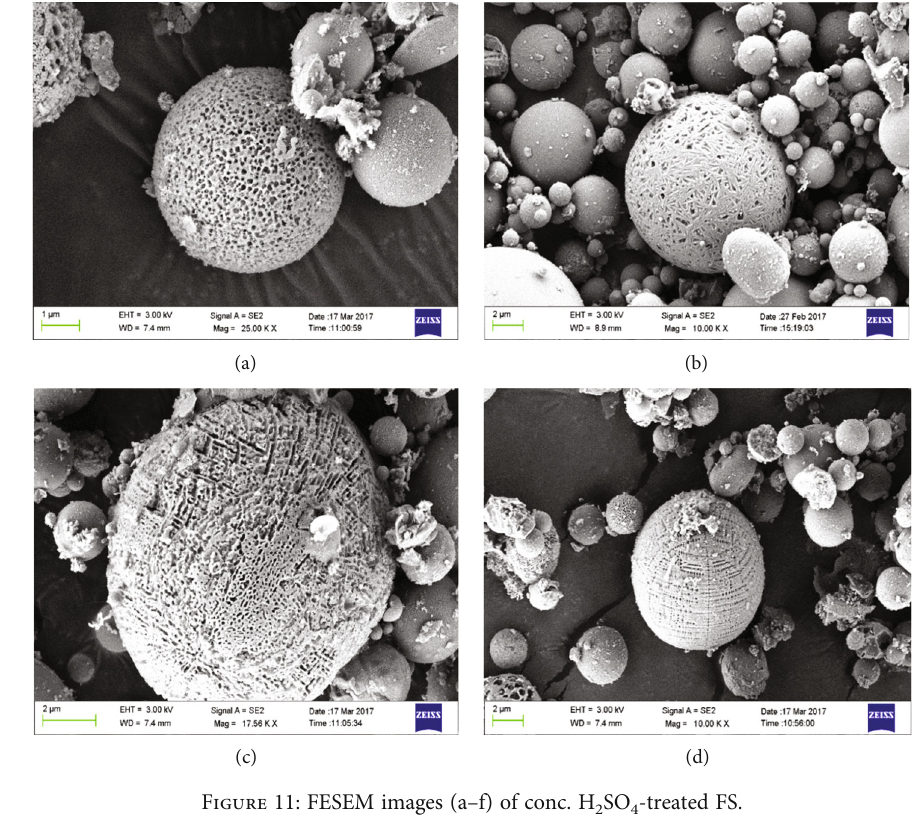
SO -treated FS. 2 4